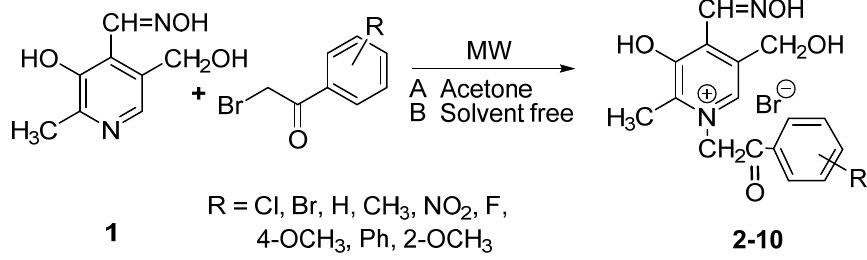
Scheme 1. A general schematic representation for the preparation of quaternary salts of pyridoxal oxime.